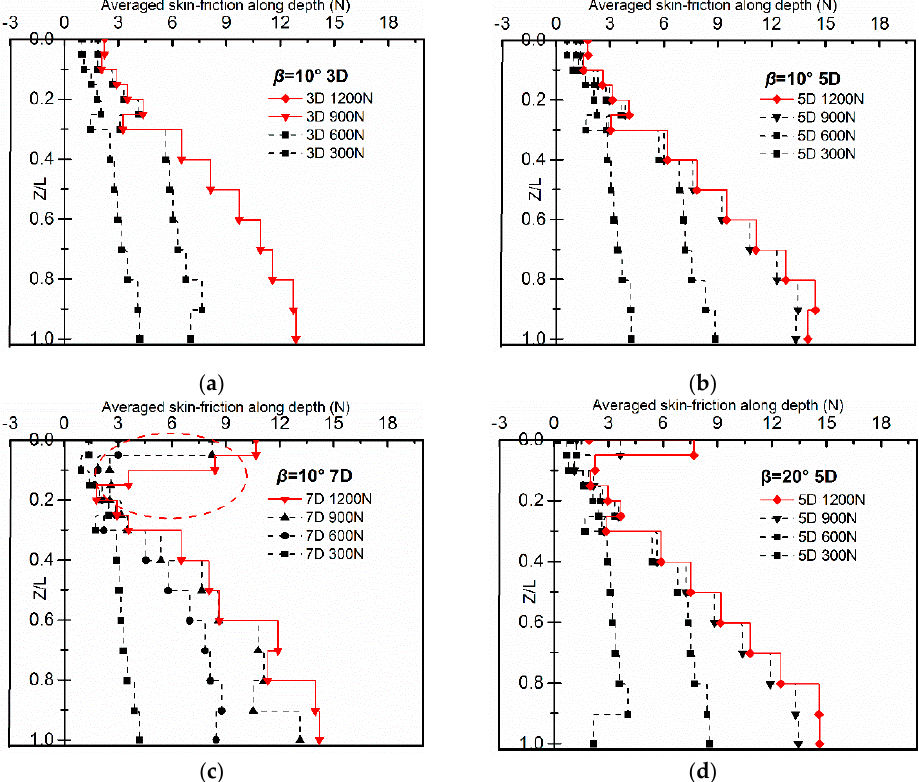
Figure 10. The variation in averaged skin-friction along depth: ( a ) β = 10° pile spacing = 3 D , ( b ) β = 10° pile spacing = 5 D , ( c ) β = 10° pile spacing = 7 D , and ( d ) β = 20° pile spacing = 5 D.